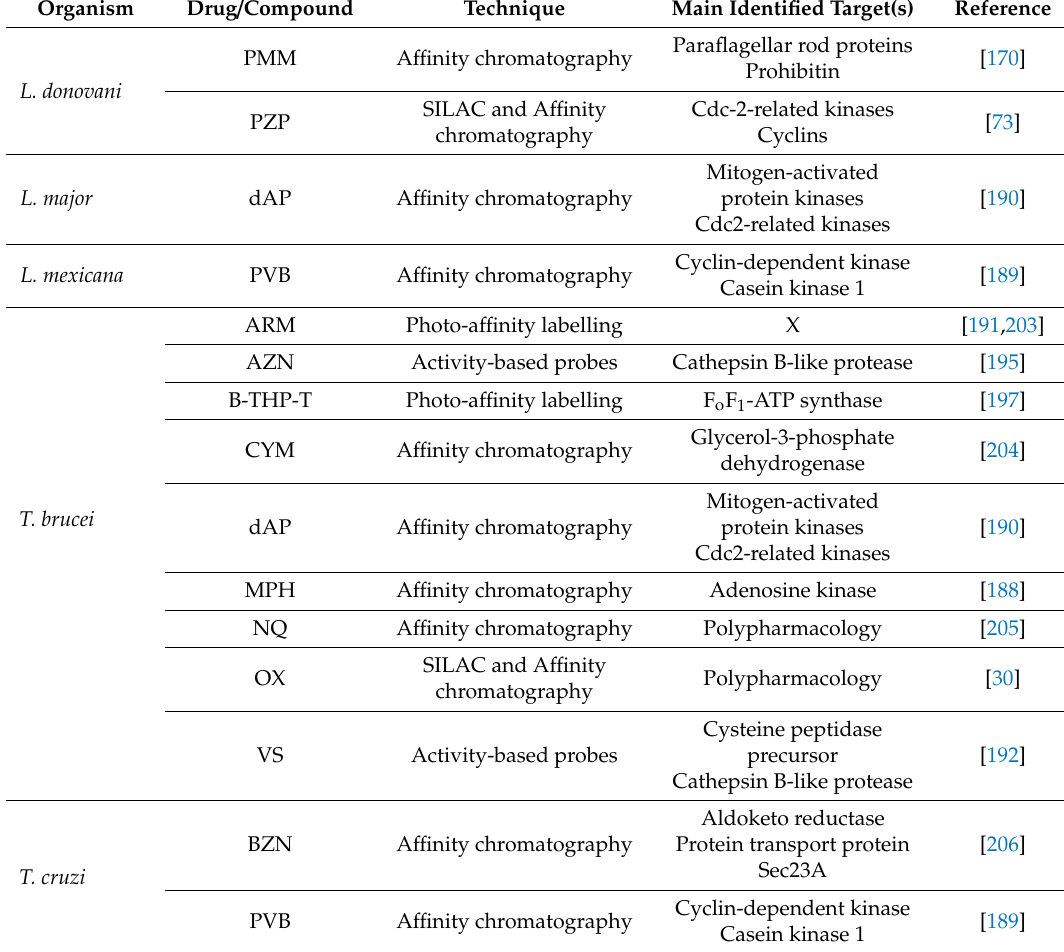
Table 5. Use of chemical proteomics to unravel the MoA of anti-kinetoplastid drugs. Experiments with Leishmania spp. and T. cruzi were performed on promastigotes and epimastigotes,